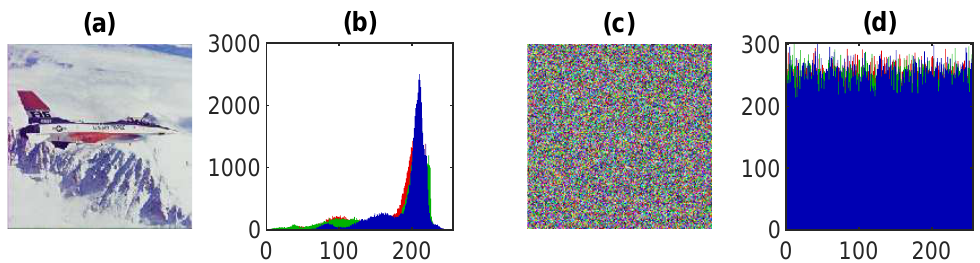
Figure 8. Histogram analysis of the image in Figure 2a: ( a ) the original image, ( b ) histogram of the original image, ( c ) encrypted image, ( d ) histogram of the encrypted